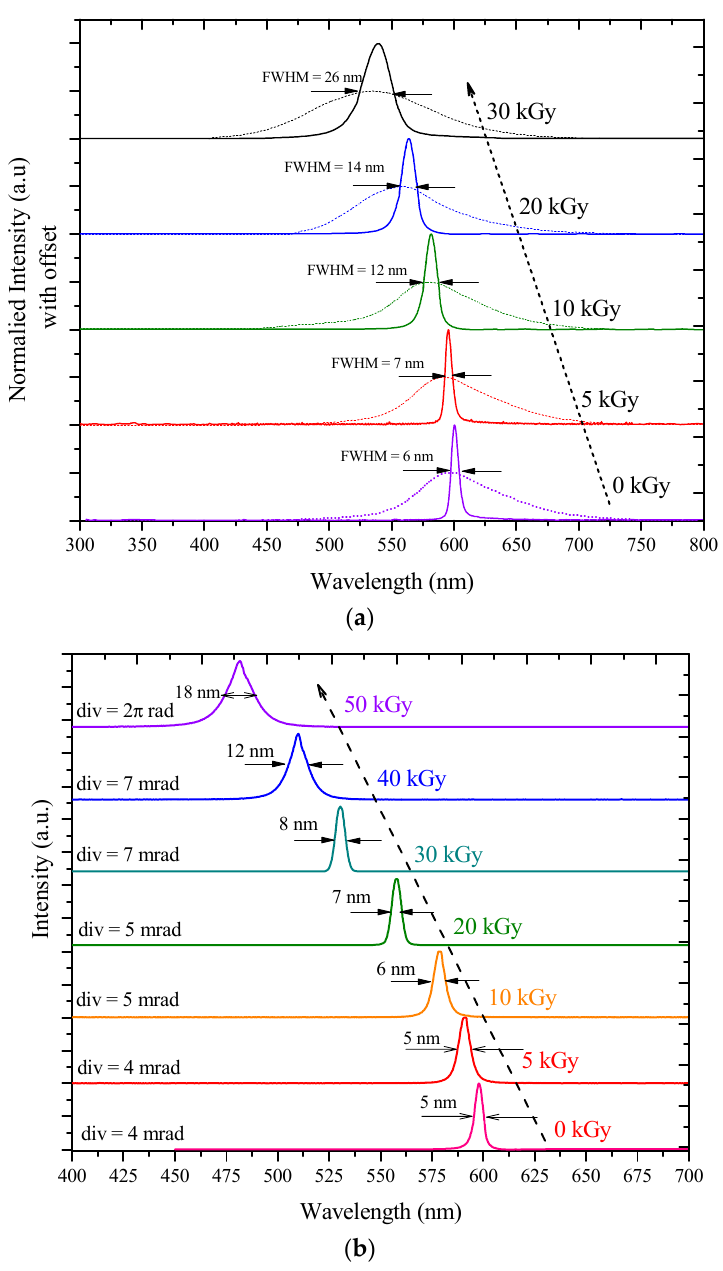
Figure 5. ( a ) The ASE spectrum of the MEH–PPV in THF at 50 μ M concentration for different dose ranging from 5 to 30 kGy; dotted line represents laser induced fluorescence (LIF) and solid line represents Amplified Spontaneous Emission (ASE). ( b ) The ASE spectrum of the BMP in THF at 5 mM concentration for different dose ranging from 5 to 50 kGy.